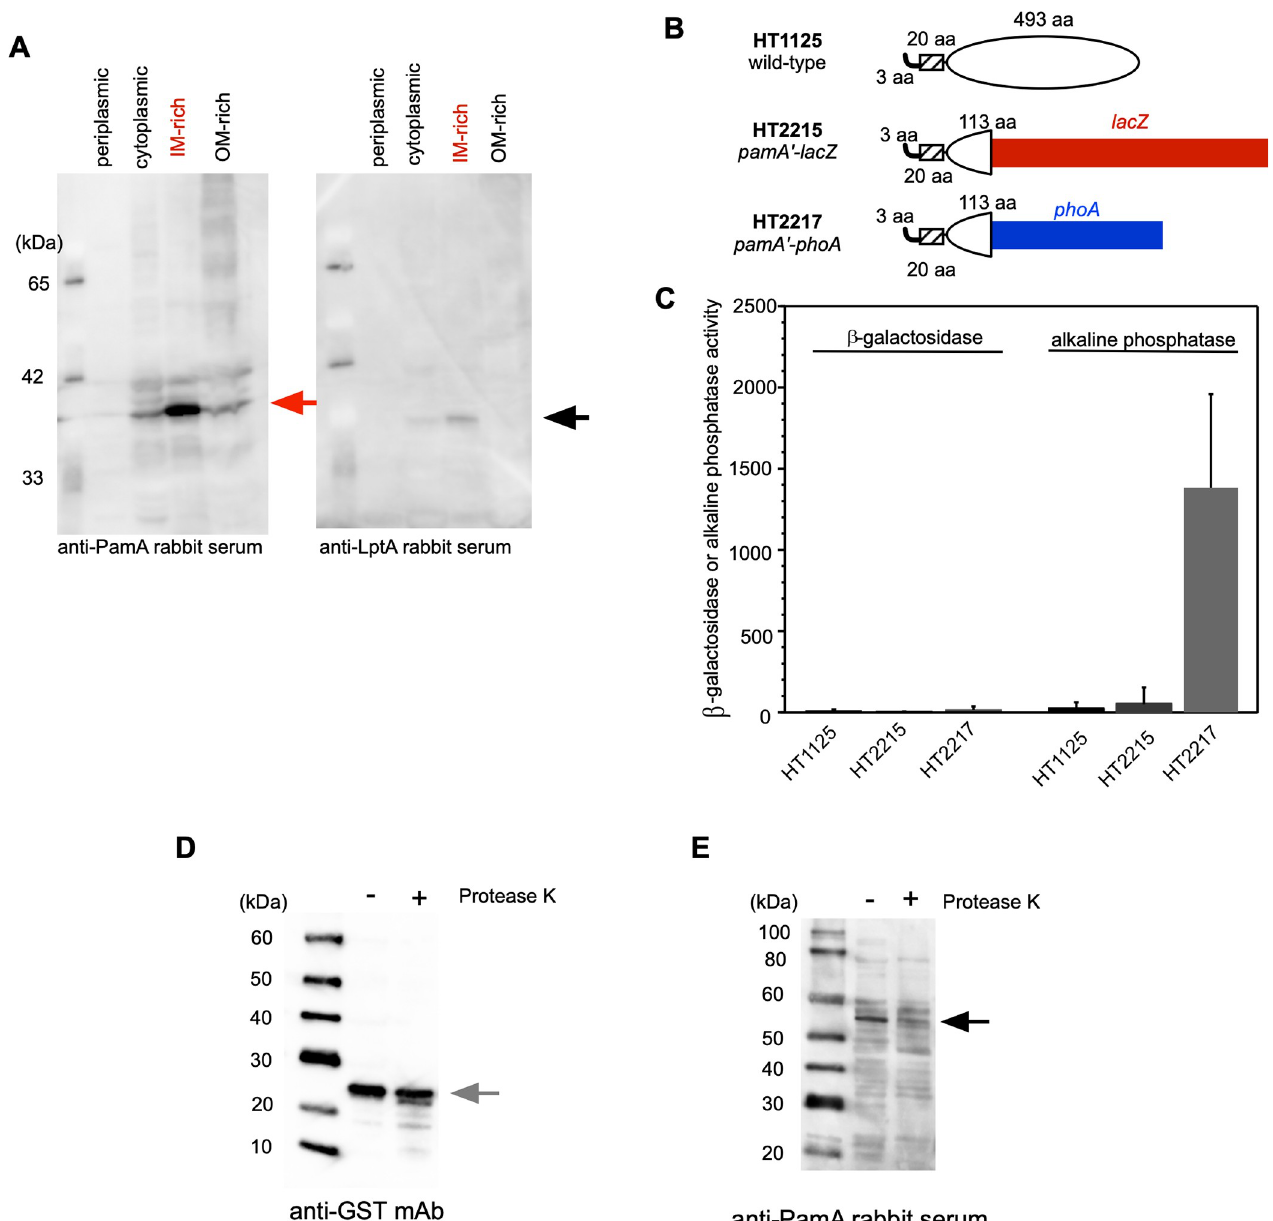
Fig 2. Characterization of the biochemical properties of the PamA protein in N . meningitidis . (A) Western blot analyses of subcellular fractions of the PamA protein in N . meningitidis strain HT1125. A whole-cell lysate periplasmic fraction (P) isolated by CHCl 3 shock, cytoplasmic and periplasmic fraction (CP), IM-enriched fraction, and outer membrane (OM)-enriched fraction were prepared by the sonication method from the N . meningitidis strain, as described previously [45]. Western blotting with anti-PamA (left) and anti-LptA (right) [55] rabbit antisera. LptA is a control for the proper isolation of the IM- rich fraction. Black and gray arrows show PamA and LptA, respectively. (B) Membrane topology of the PamA protein using the pamA 0 -lacZ and pamA 0 -phoA fused N . meningitidis strain. The hatched region consists of the 20 amino acid residues corresponding to the putative membrane-spanning region (S1 Fig). The first 408-bp region of the pamA gene was fused to the lacZ or phoA gene, and the gene was incorporated into the pamA locus on the meningococcal chromosome. (C) β -Galactosidase and alkaline phosphatase activities. (D,E) Western blot of spheroplasted N . meningitidis strain H44/76 harboring pHT936 (an IncQ plasmid expressing the gst + gene, Table 1) followed by a treatment with Proteinase K. Aliquots of the sample were analyzed by Western blotting with anti-GST mAb (D) and anti-PamA rabbit serum (E). Black and gray arrows show PamA and GST, respectively.